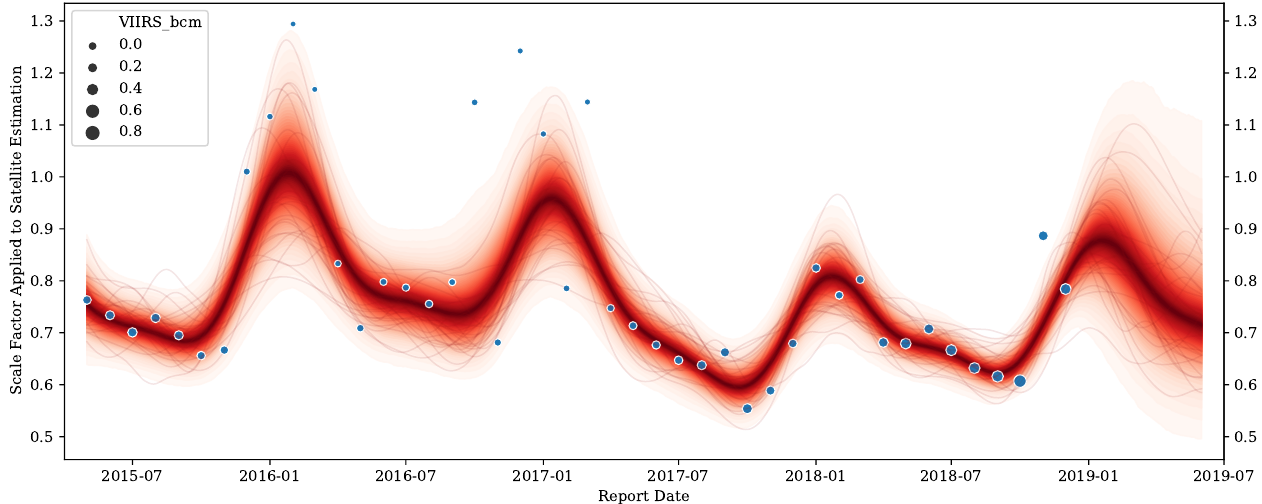
Figure 14. Posterior predictive samples showing predictions of the scale factor for the next six months. Blue points stand for the observed data while red lines denote thirty posterior samples. Larger points indicate greater flaring magnitude as observed by